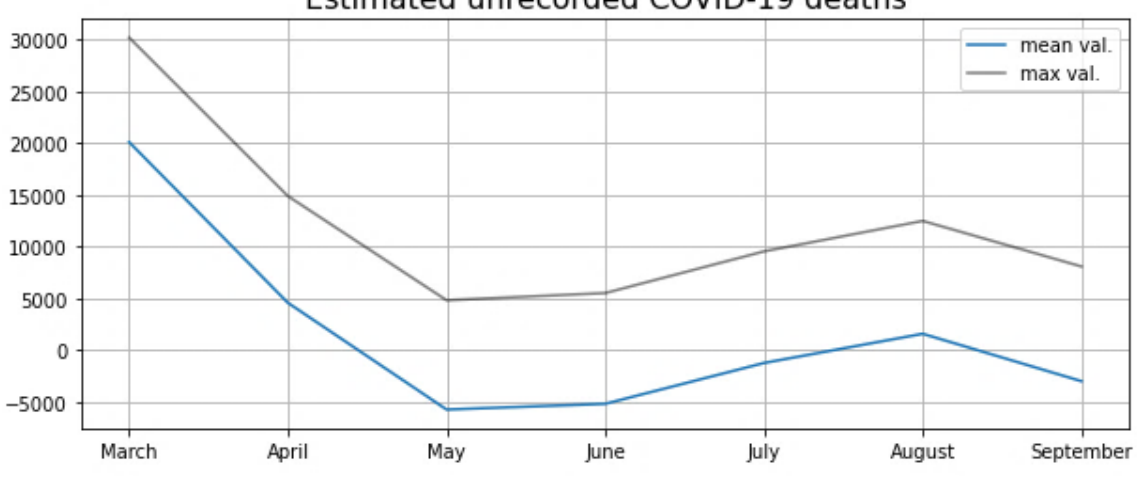
Figure 18. Trend of estimated unrecorded COVID-19 deaths in Italy